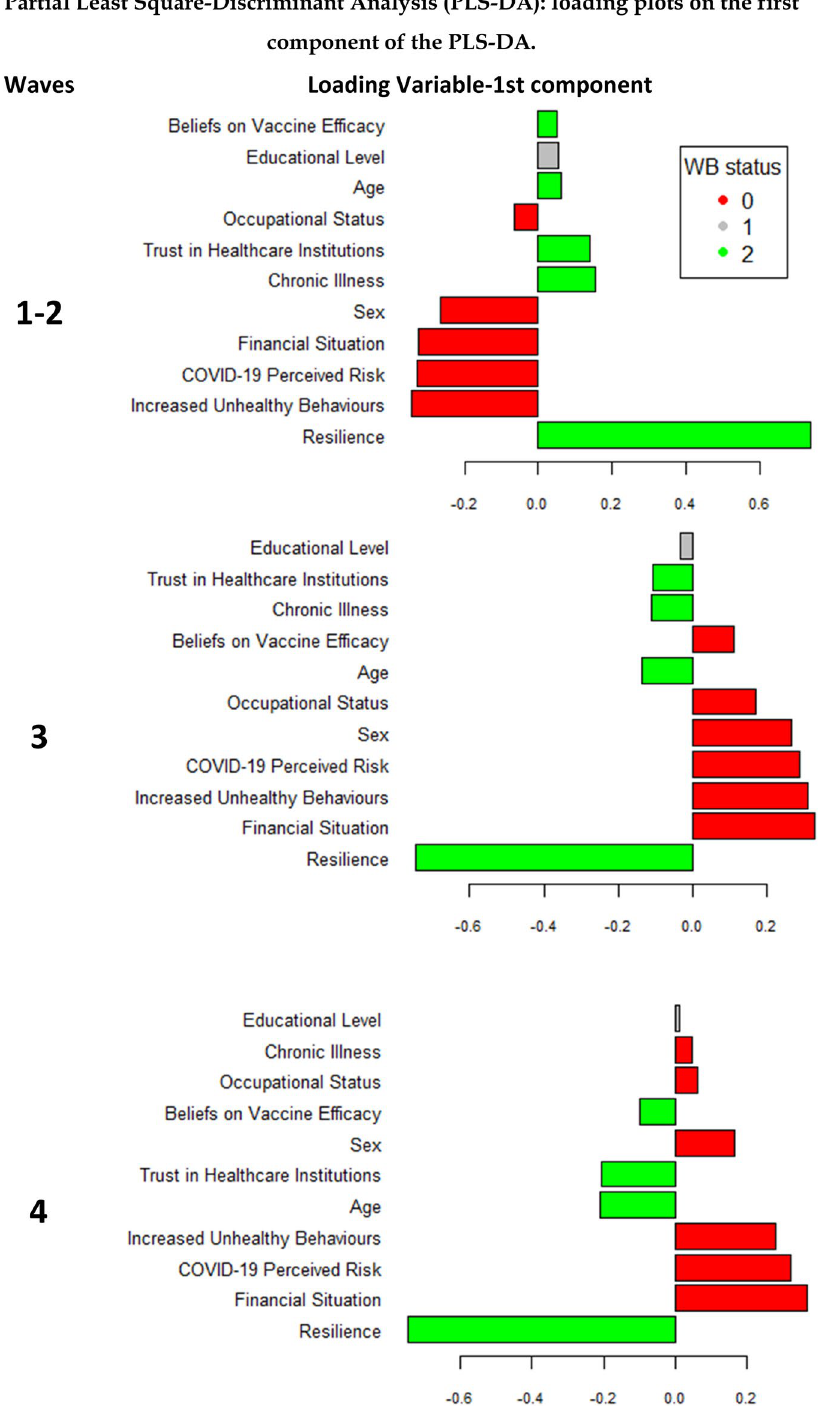
Figure 2. Partial Least Square-Discriminant Analysis (PLS-DA): loading plots on the first component of the PLS-DA. WB status: Well-being status: red 0 = Depression; gray 1 = Poor Well-being; green 2 = Well-being. Loadings plot assigns to each variable bar the sample group colour for which the mean is